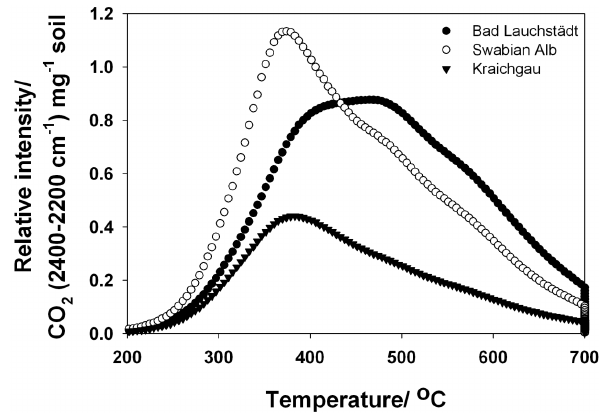
Figure 5 Fig. 5. FTIR-EGA average CO 2 thermograms of soils from three different agroecological sites (Bad Lauchst¨adt, Kraichgau, Swabian Alb). ∗ Normalized intensity is the integrated area of the CO 2 peak from 2400 to 2200cm − 1 normalized to weight of the sample.